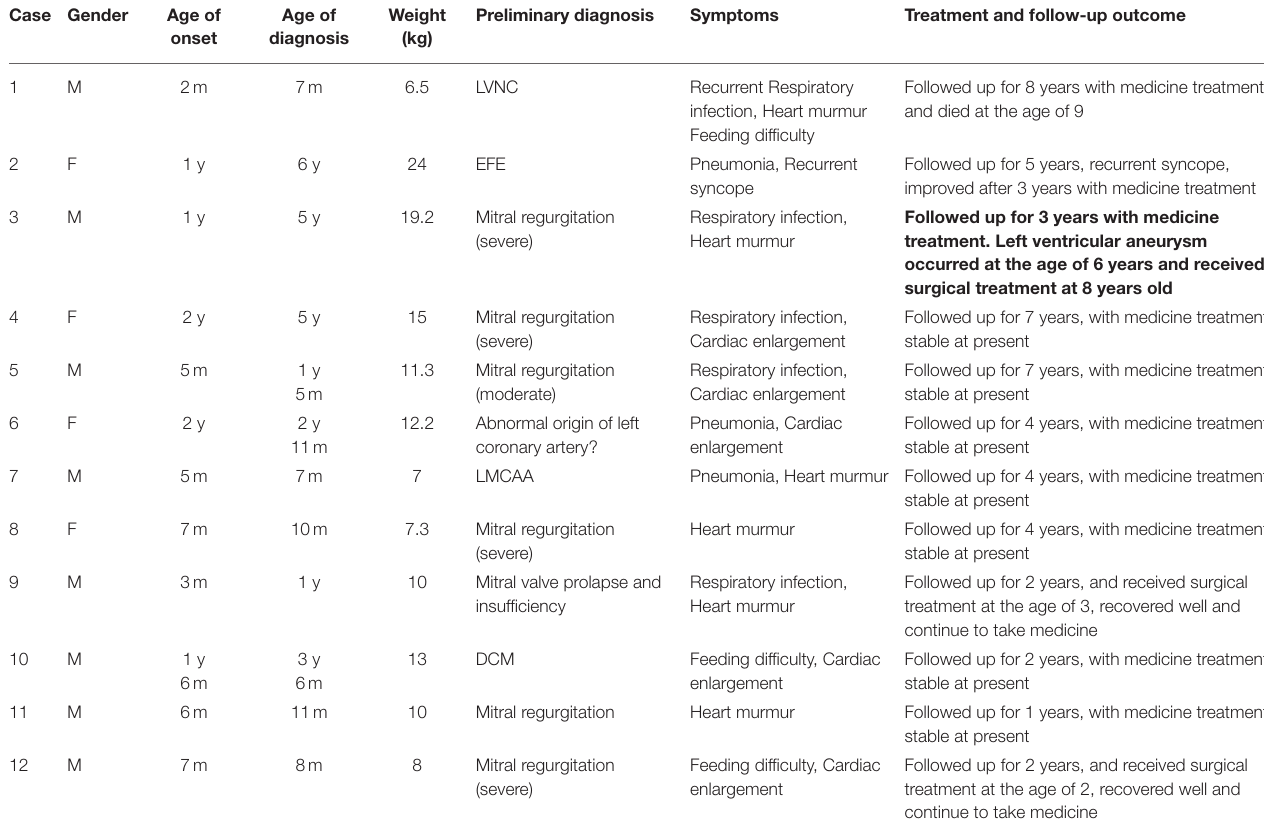
TABLE 1 | Clinical data of atresia of the left main coronary artery in 12 children. Case